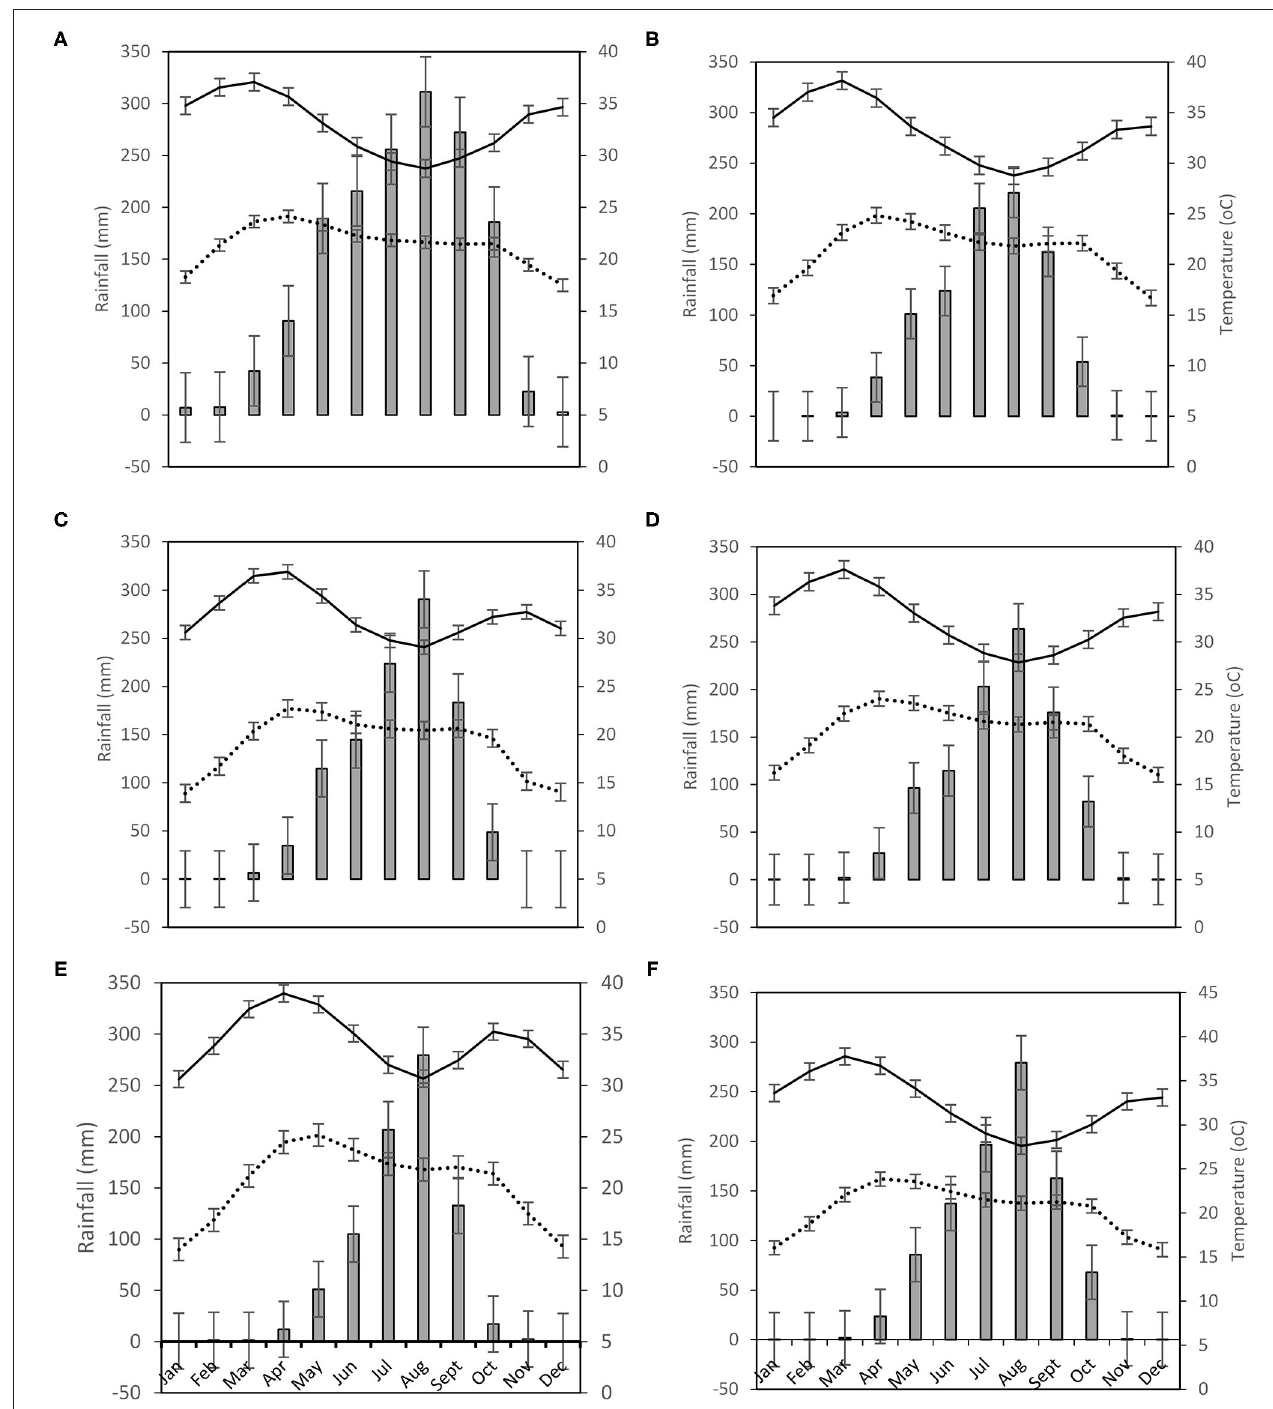
FIGURE 1 | (A–F) Cumulative monthly rainfall and temperature over a 31-year period (1985–2015) for Abuja (A) , Yelwa (B) , Zaria (C) , Sabon Gari (D) Kano (E) , and Balbaya (F) Source of data: NIMET (2016) and CHIRPS, Funk et al. (2015).